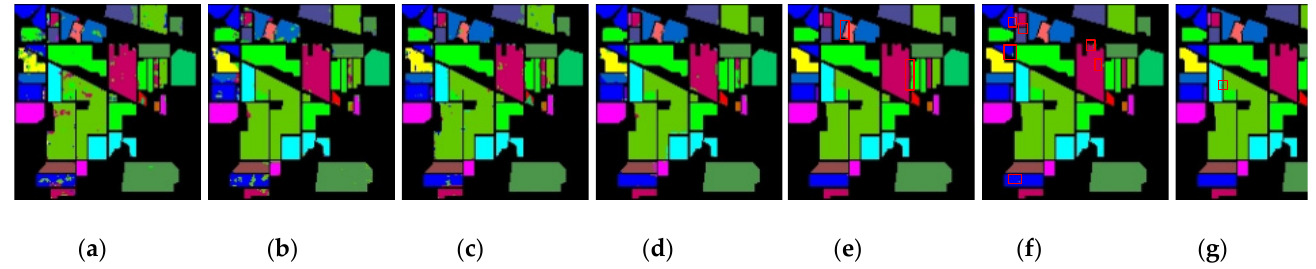
Figure 14. The classification map on the SA dataset for ( a ) SVM, ( b ) 3D-CNN, ( c ) SSAN ( d ) SSRN, ( e ) HSI-BERT, ( f ) SAT, and ( g ) proposed 3DSA-MFN. Red boxes are used to mark non-obvious misclassifications and noise.